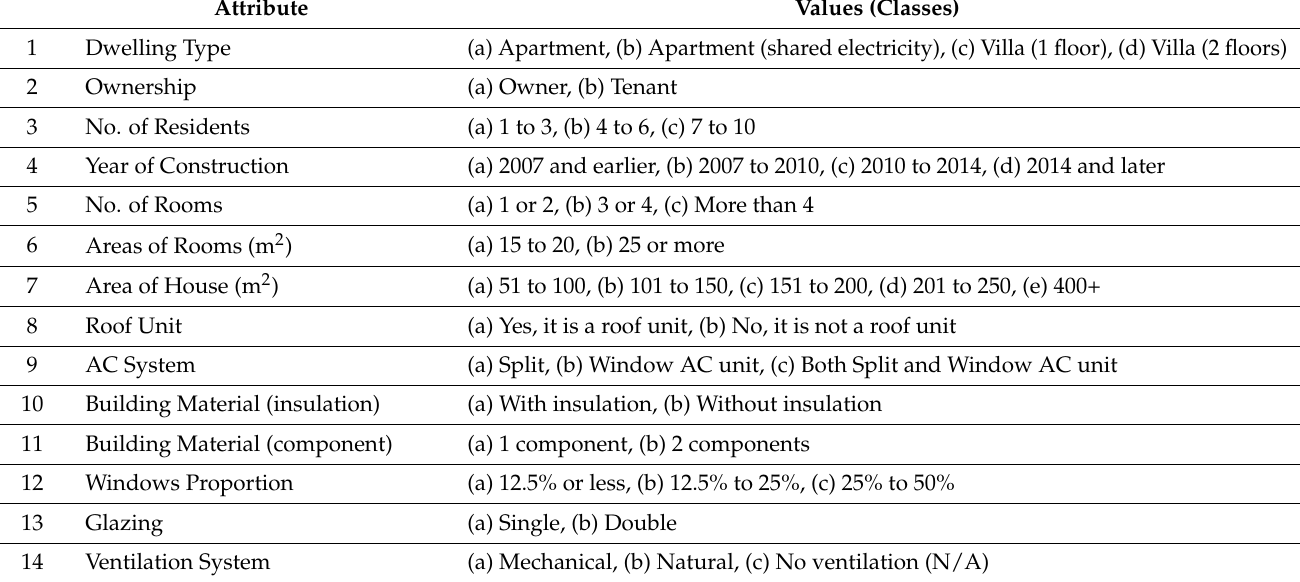
Table 6. Attributes of the households.